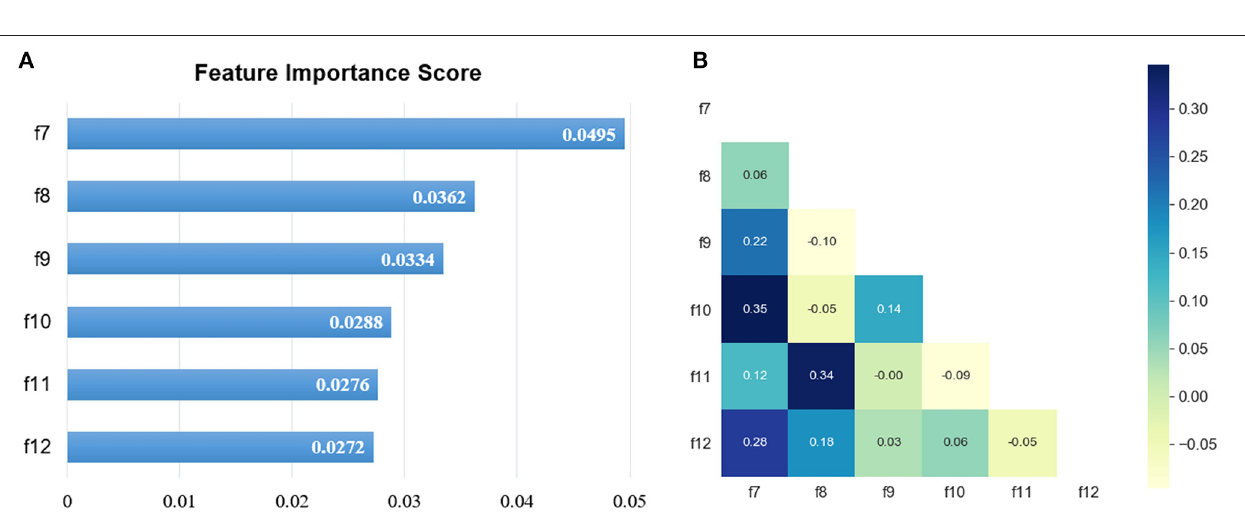
FIGURE 3 | The selected mediastinal window features. (A) The RSF-based feature importance score; (B) the correlation heatmap.